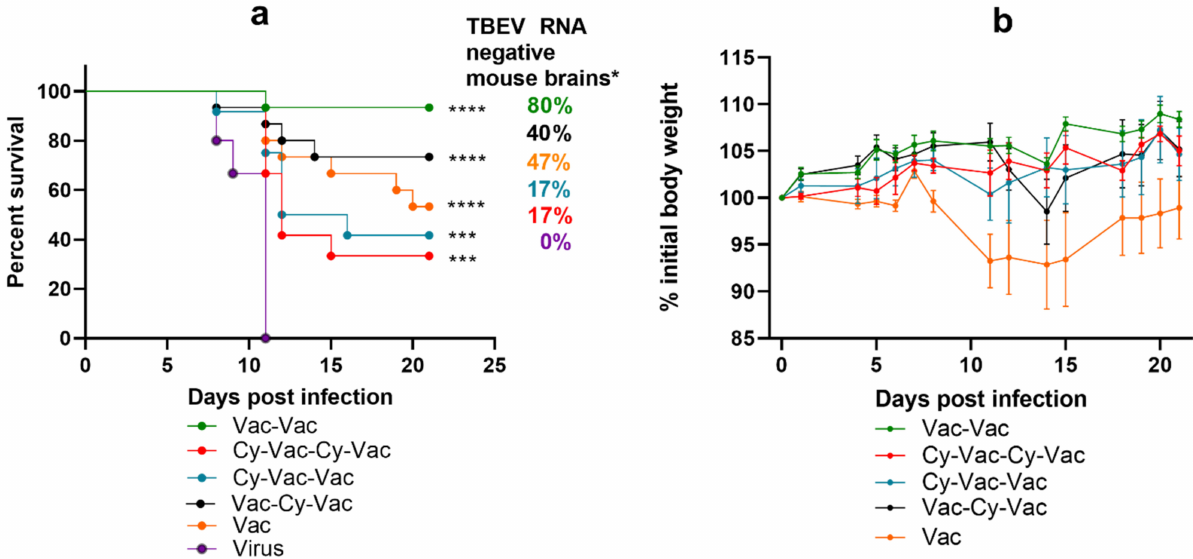
Figure 4. Survival and weight changes in BALB/c mice with and without high-dose Cy immunosupression. Mice were vaccinated with TBE vaccine Tick-E-Vac and challenged with 100 LD 50 of TBEV strain Vasilchenko. ( a ) Survival curves for vaccinated and control mice. ( b ) Weight changes after the virus challenge. Error bars represent SEM. Vac-Vac group was used as a control without Cy treatment (green); Cy-Vac-Vac received Cy treatment before the first vaccine dose (blue); Cy-Vac-Cy-Vac was treated with Cy twice: before the first and the second vaccine doses (red); Vac-Cy-Vac received Cy treatment before the second vaccine dose (black) and Vac was vaccinated only once (orange). N = 12–15 animals per group. Data only for mice surviving till 21 dpi was used for weight curves. * All brain samples from dead mice were considered RNA-positive. Statistical significance for mortality data was determined by log rank test (*** p < 0.001; **** p <